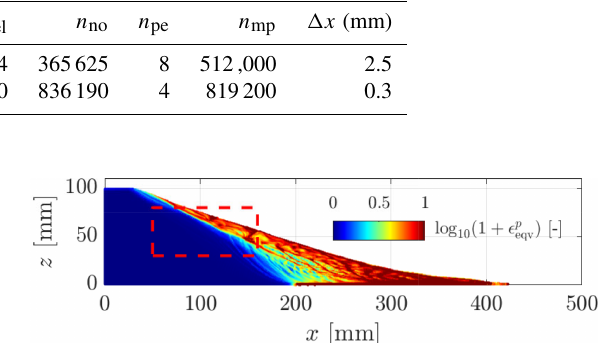
Figure 9. Equivalent plastic strain (cid:15) p eqv for the final configuration of the granular collapse. The dashed red rectangle denotes the lo- cation of the zoomed-in region in Fig. 10a. One can observe more complex plastic strain localizations compared to the numerical re- sults obtained in Fig. 7 for a three-dimensional configuration with a coarser background mesh